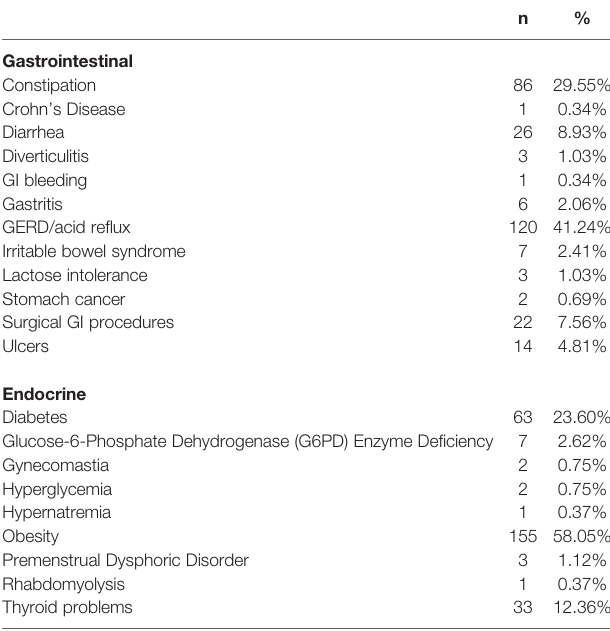
schizophreniform disorder, or schizoaffective disorder (26).